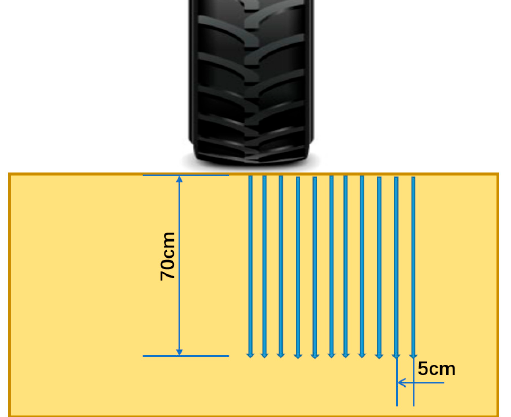
Figure 6. Soil cone index measurement using the penetrometer at 0–70 cm depth vertical and 5 cm each horizontal.